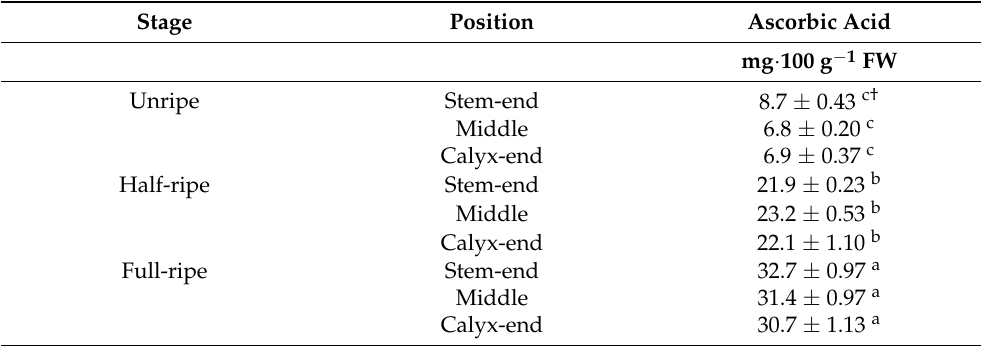
† Different letters within columns indicate significant differences by Duncan’s multiple range test. Table 7. Changes in macronutrients of “Tainung No. 2” Red papaya ( Carica papaya ) pulp at 3 parts across ripening stages: unripe at 16 weeks after anthesis (WAA), half-ripe at 18 WAA, and full-ripe at 20 WAA.